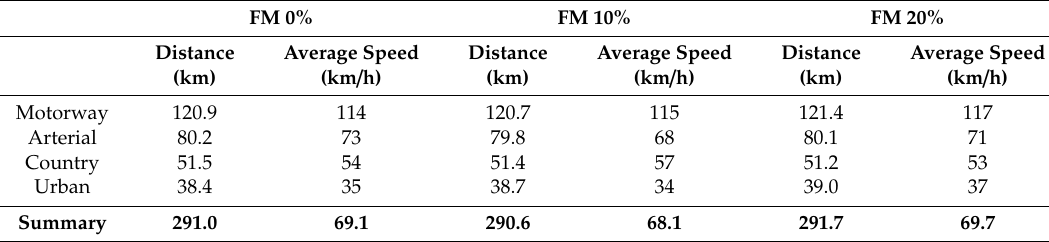
Figure 4. Route measured for this study. Table 2. Specifications of the route and vehicle speed for the van used in this study.